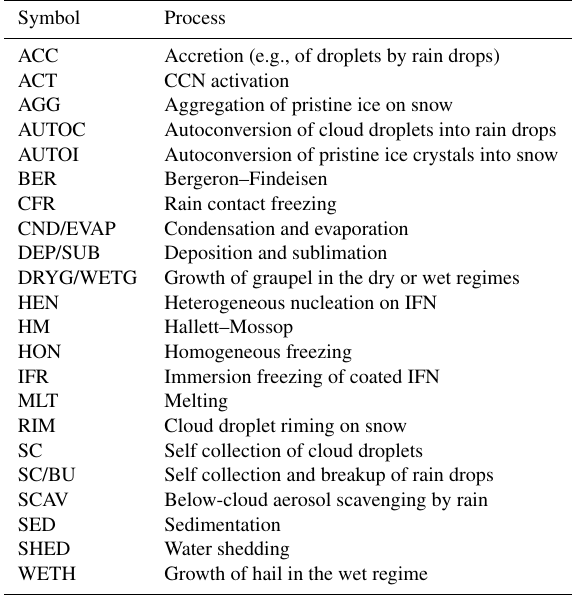
Table 2. List of the microphysical